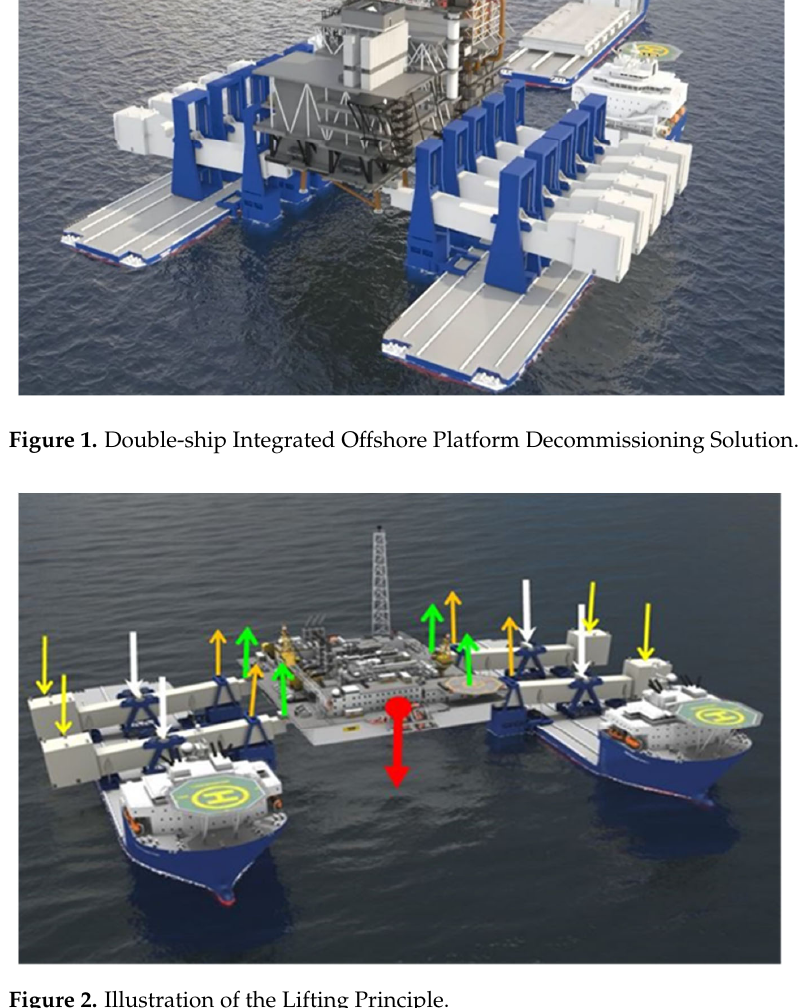
Figure 1. Double ‐ ship Integrated Offshore Platform Decommissioning Solution.